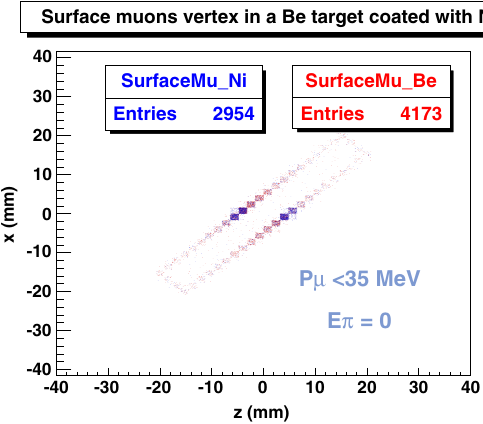
FIG. 7. Variation of the surface muon yield as a function of slabs distance for a 45 degrees angle orientation. The muons are detected by the ISIS beam window and the appropriate selection cuts are